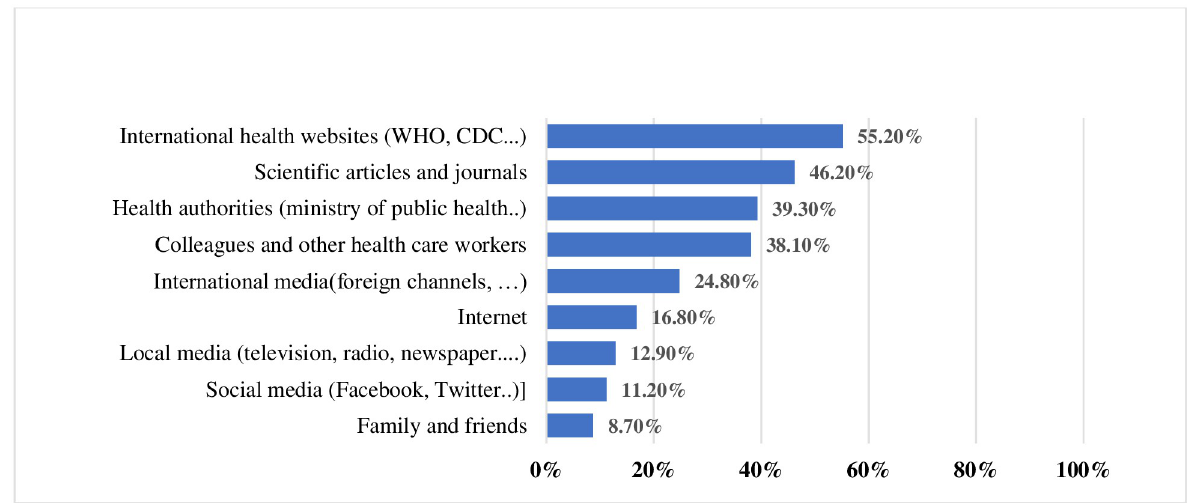
Fig 3. Reliable sources of information about COVID-19 vaccines as perceived by HCWs.